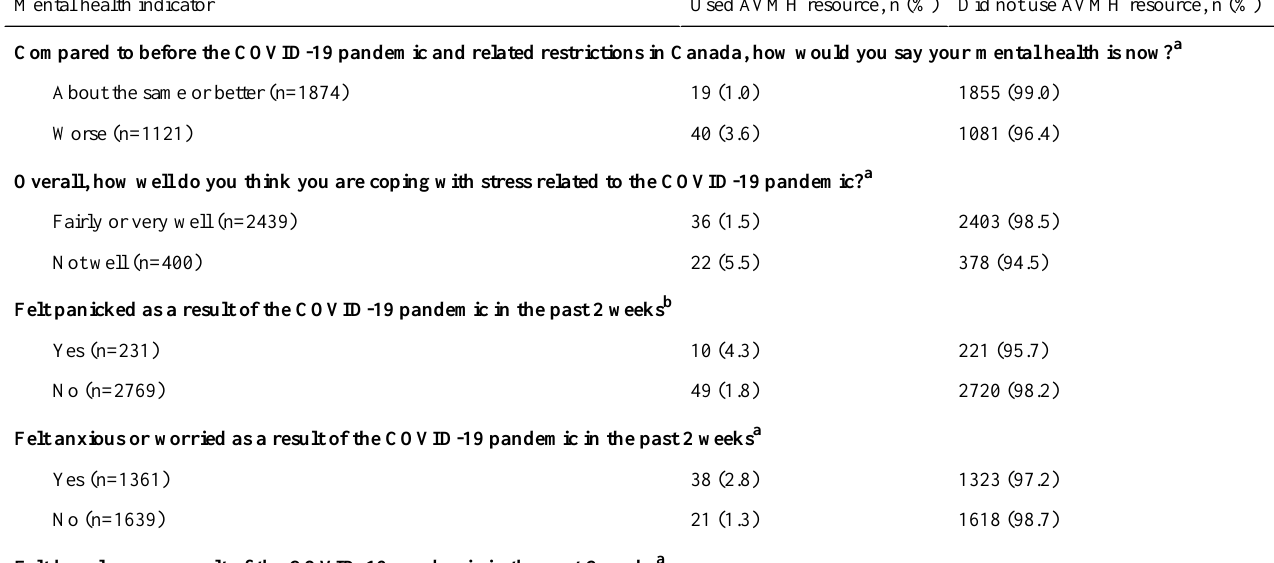
Compared to before the COVID-19 pandemic and related restrictions in Canada, how would you say your mental health is now? a